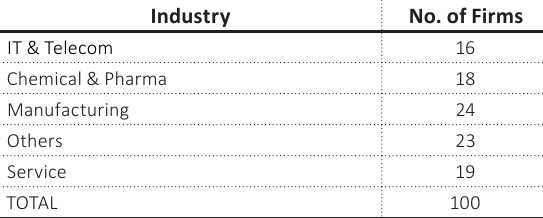
Table 1. Selected industries and number of firms Industry No. of